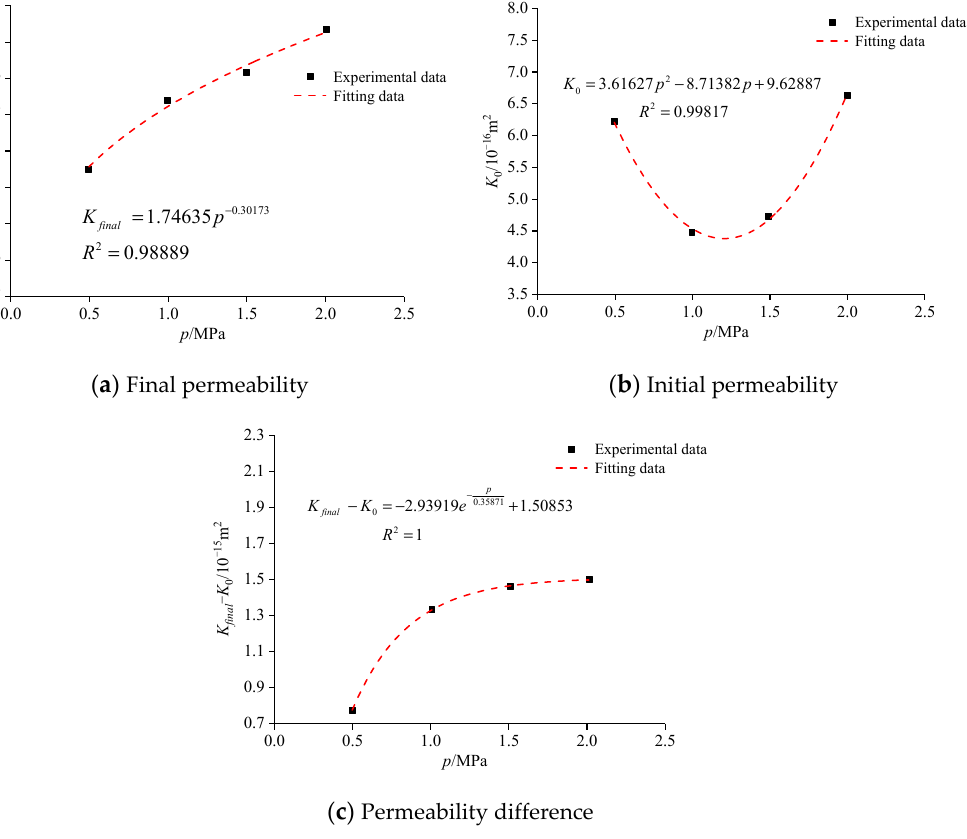
Figure 11. Permeability variation of axially unloaded coal samples under a constant CP of 4 MPa and different GPs: ( a ) final permeability; ( b ) initial permeability; ( c ) permeability difference.